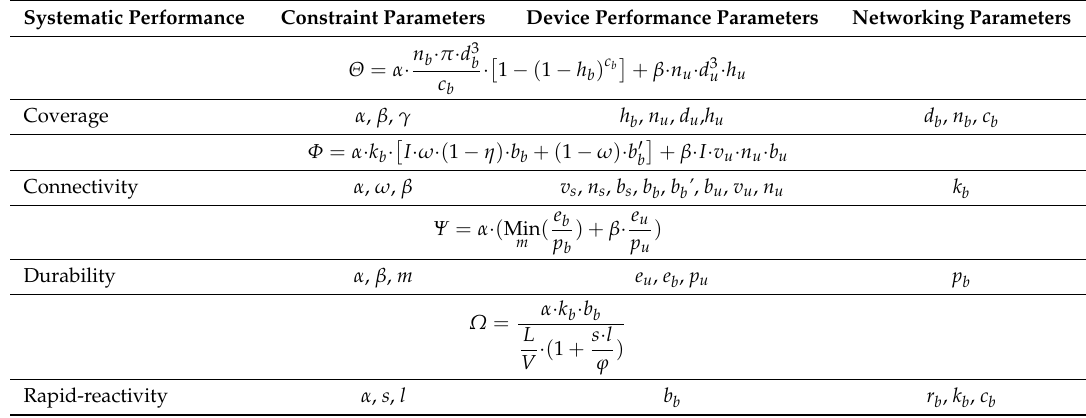
Table 2. Parameter categories in the Systematic Performance Measurement